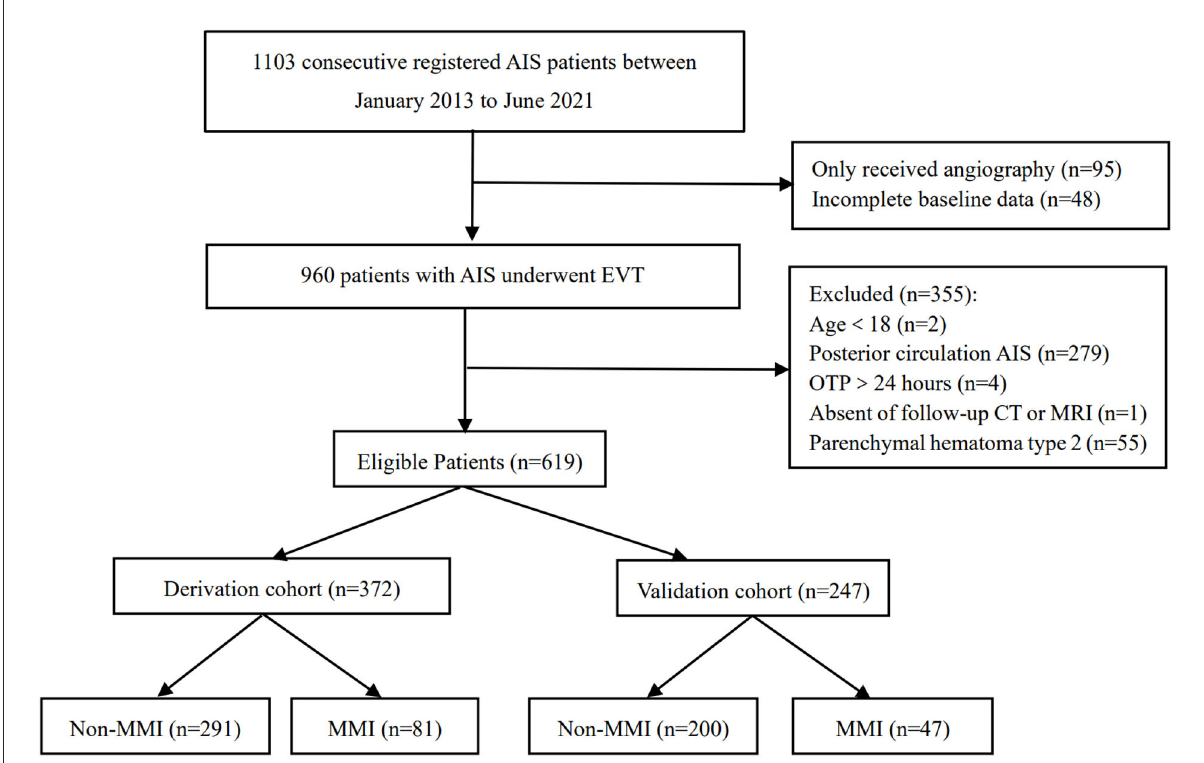
FIGURE1 A flowchart of the patients enrolled in the study. AIS, acute ischemic stroke; EVT, endovascular therapy; OTP, time interval from symptoms onset to puncture; MMI, malignant middle cerebral artery